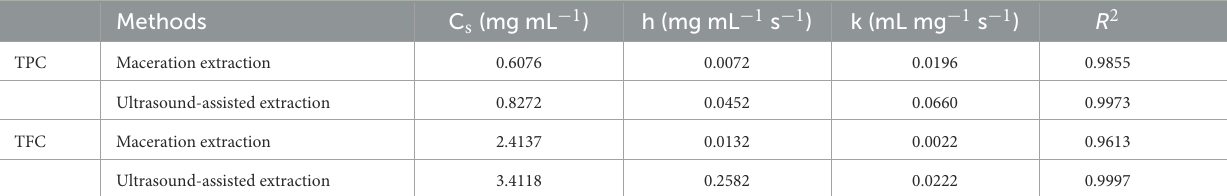
TABLE 1 Parameters of the second-order rate model of propolis extraction with maceration and ultrasound-assisted extraction.